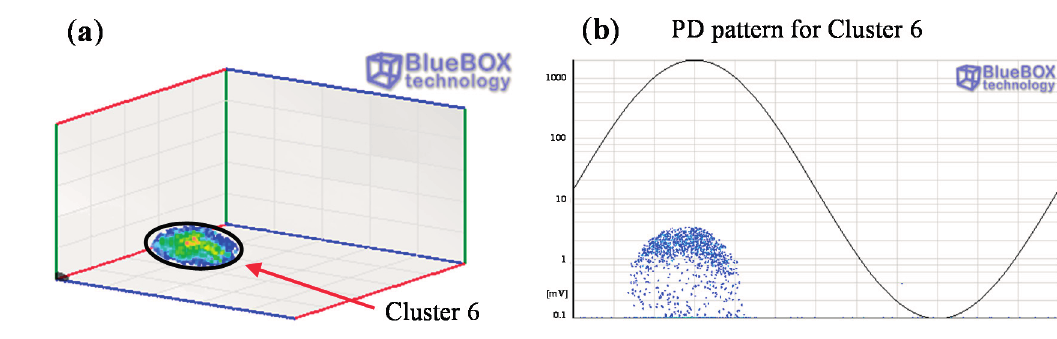
Figure 26. ( a ) Cluster 6 detected with the sensor HFCT 1; ( b ) PRPD pattern corresponding to cluster